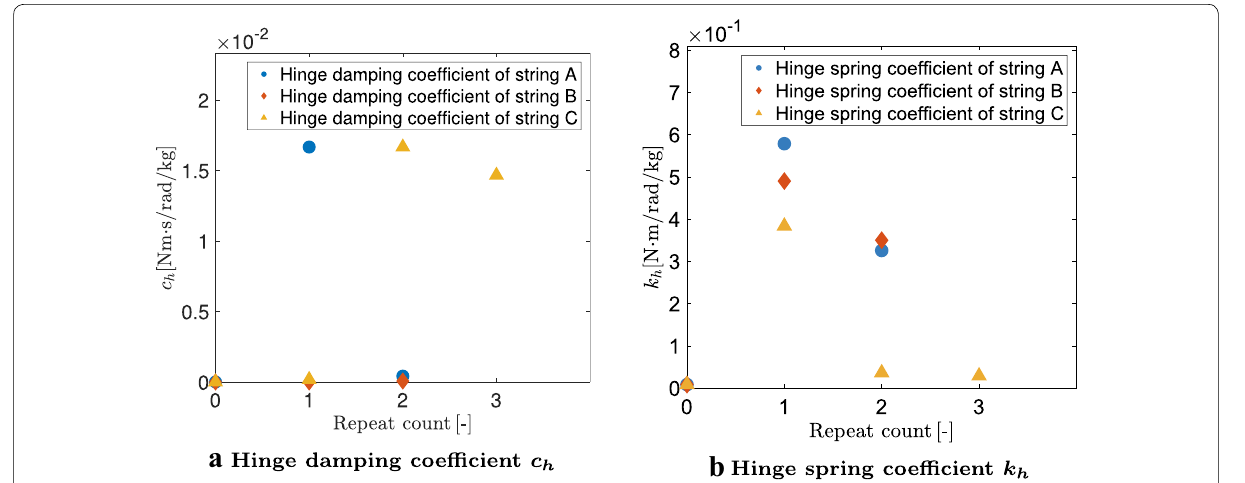
Fig. 21 Estimated parameters for each string (desired image of string: J)